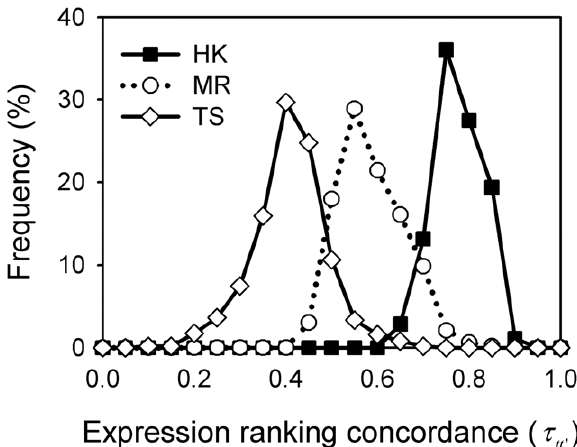
Figure 1. HK genes exhibited a significantly more preserved expression ranking order than MR or TS genes. Frequency is the percentage of tissue pairs with the indicated Kendall’s tau ( t tt 0 ). Each ~ 630 Kendall’s tau ( t distribution is a compilation of C N t ~ 36 tt 0 ; Equation 2 (3) ), where each t tt 0 was for a pair of tissues sampled from a 36-tissue pool and the frequency of t tt 0 at a particular value was computed on a histogram using a bin width of 0.1. The average value ( (cid:2) tt tt 0 ) of the t tt 0 distribution for the HK, MR, and TS gene sets was 0.77, 0.59, and 0.41, respectively, and the standard errors were all small, mostly less than 0.01.